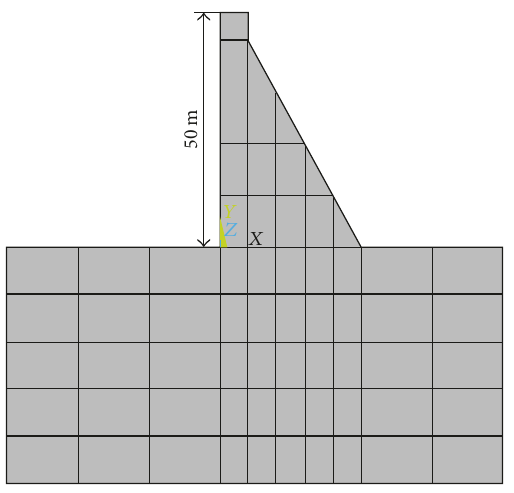
Figure 3: Block element meshes for DDA analysis